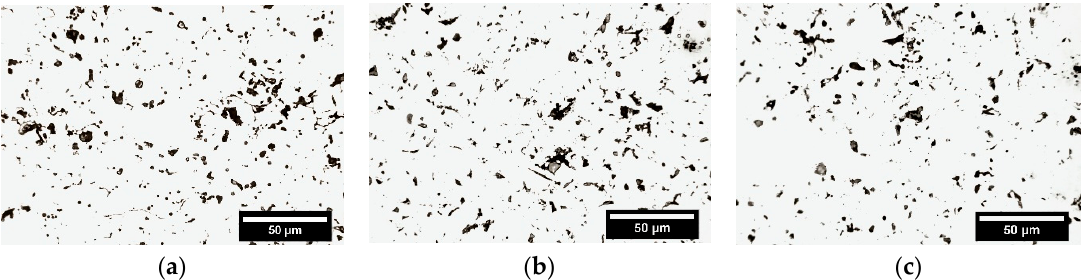
Figure 7. Examples of micrographs used for the studies of porosity in products sintered by various methods: ( a ) conventional process: 1120 ◦ C/30 min (CS); ( b ) SPS: 1120 ◦ C/1 min (SPS-1); ( c ) SPS: 1050 ◦ C/10 min (SPS-2).